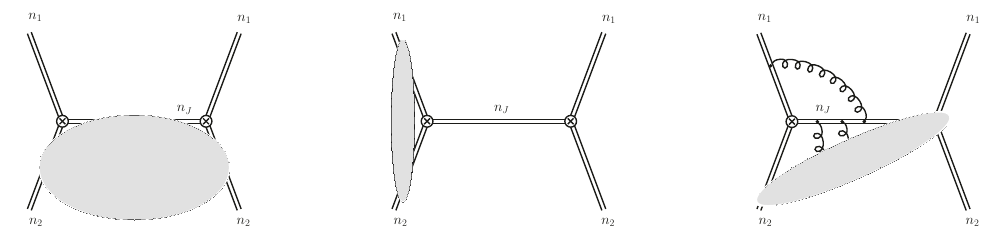
Figure 4. Using the same arguments that lead to eq. (4.4) one can show that (sub)diagrams whose integrand is independent of at least one of the lightlike vectors n i and any external invariant l 2 (where l j is an external loop momentum w.r.t. the subloop) vanish in dimensional regularization. j Examples for such diagrams are shown in this figure. The gray blob stands for all possible subdia- grams that involve the Wilson lines it